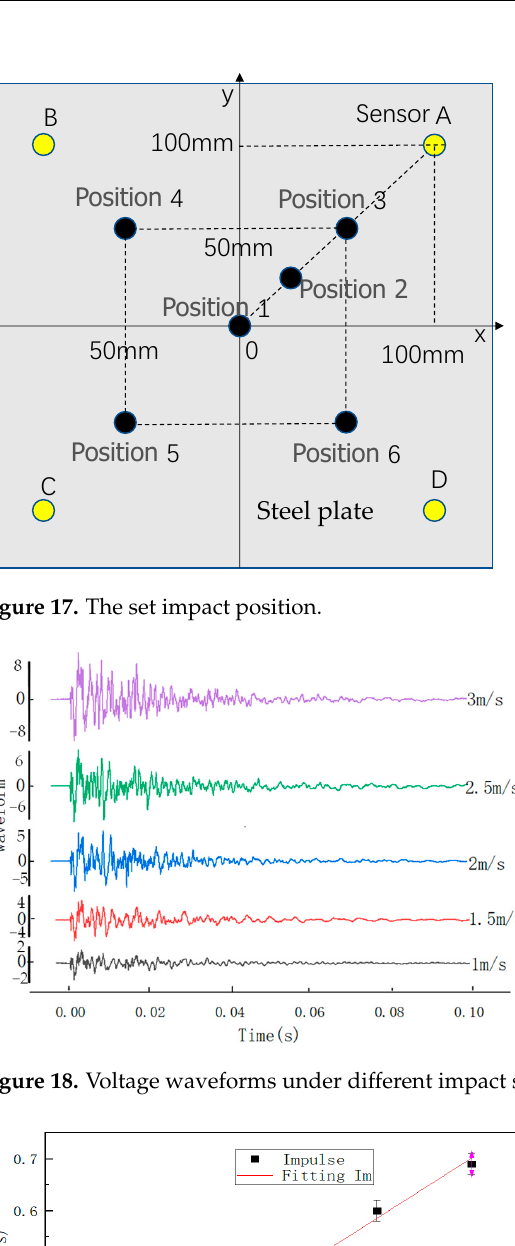
Figure 18. Voltage waveforms under different impact speeds.